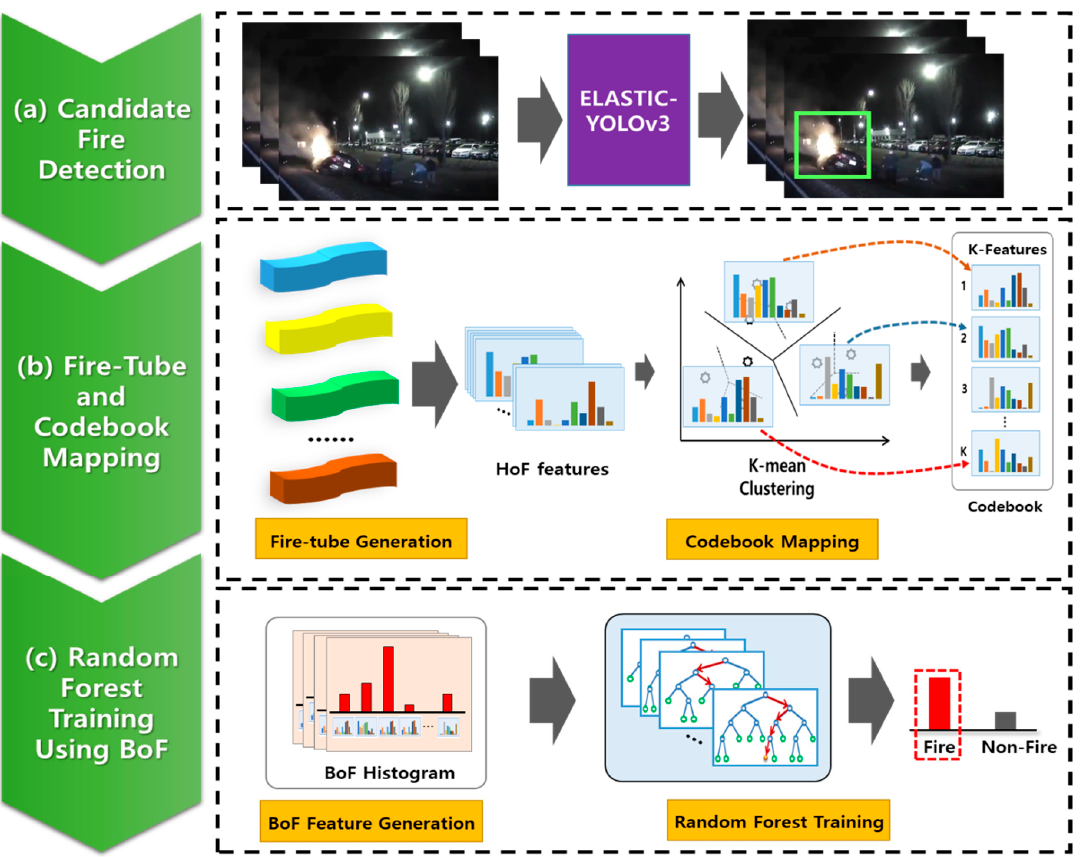
Figure 2. Overview of the proposed method for night-time fire detection: ( a ) fire candidate regions are extracted from consecutive images using ELASTIC-YOLOv3, and ( b ) a fire-tube is constructed by connecting the fire candidate areas, where the HoF are generated by the orientation of the motion vectors for estimating the temporal information of a fire-tube. Each HoF is transformed into a BoF histogram through codebook mapping. ( c ) The BoF are generated from fire and fire-like regions, and a random forest (RF) classifier is trained.